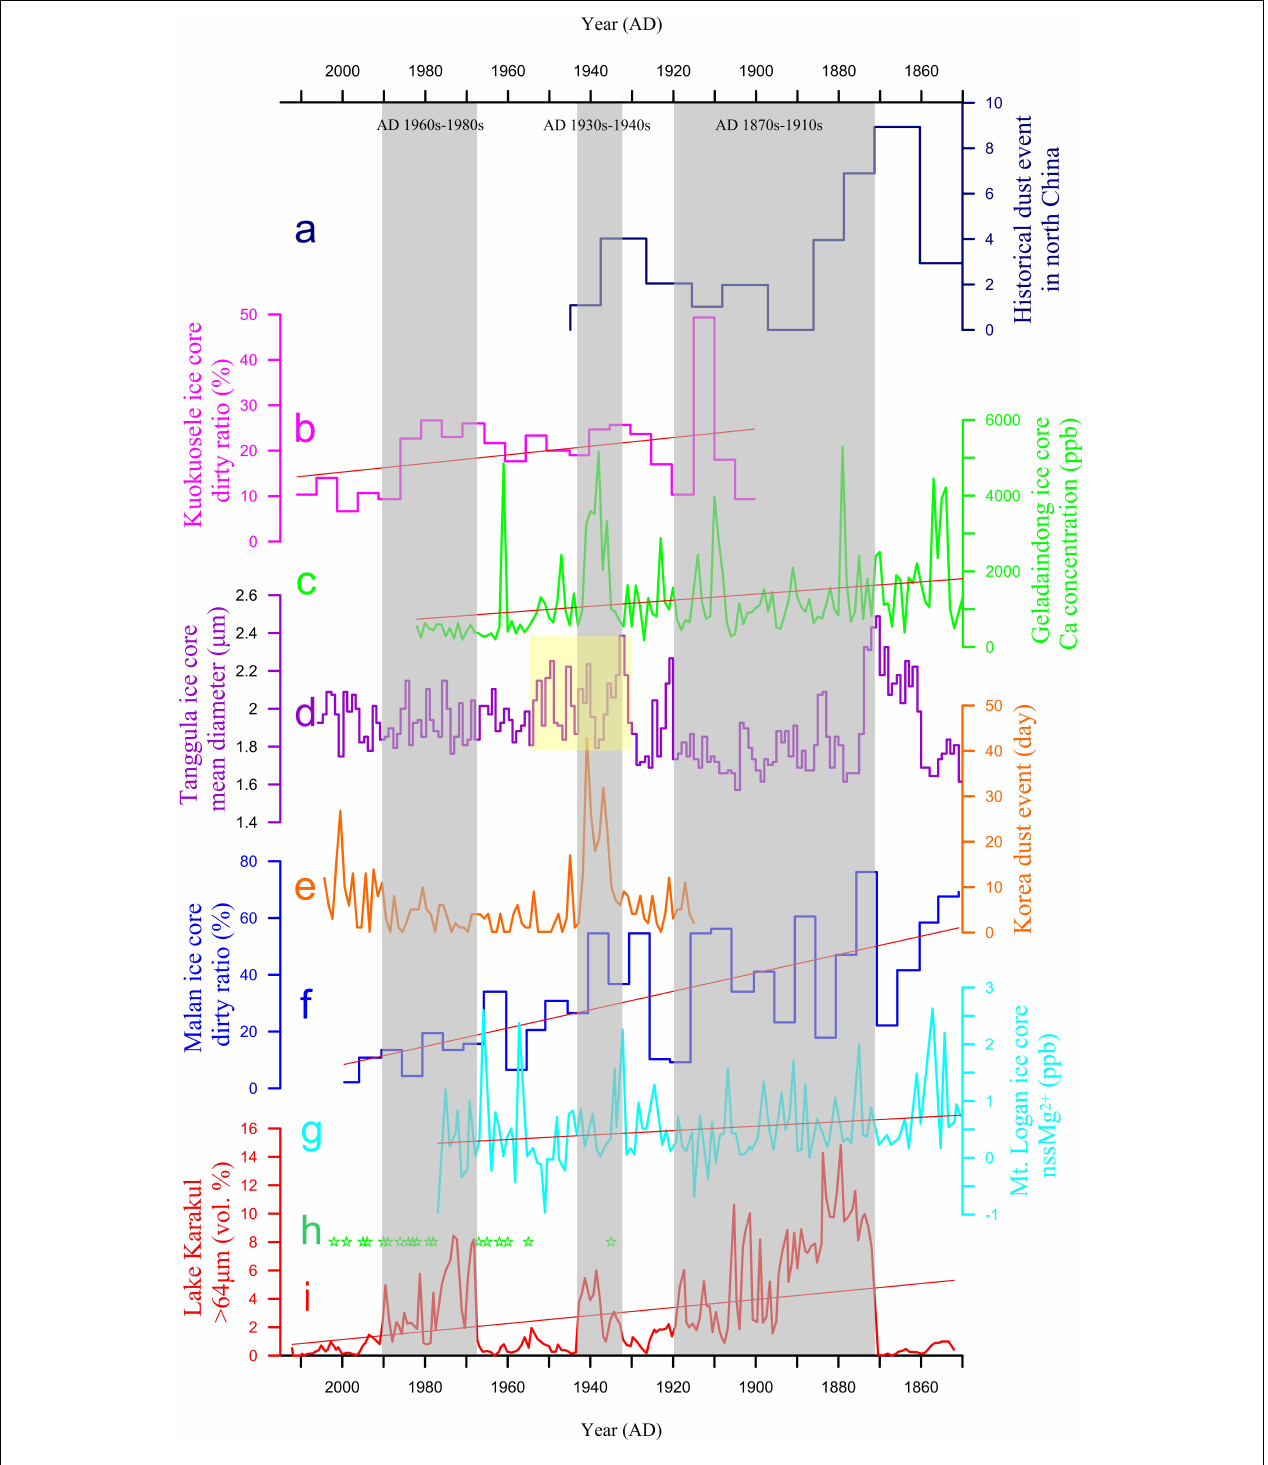
FIGURE 4 | Comparison between dust storm history at Lake Karakul (curve i; inferred from the > 64 µ m sedimentary gain-size fraction; this study), historical dust events frequency records in northern China (curve a; Zhang, 1984), dirty ratio in the Kuokuosele ice core (curve b; Tenzin et al., 2016), Ca concentrations in the Geladaindong ice core (curve c; Grigholm et al., 2015), mean diameter of dust in the Tanggula ice core (curve d; Wu et al., 2013), historical dust events in Korea (curve e; Chun et al., 2008), dirty ratio in the Malan ice core (curve f; Wang et al., 2007), nssMg 2 + from ice core in Mt. Logan, Canada (curve g; Kang et al., 2003), and historical dust event records around Lake Karakul (curve h; He et al., 2004). Red thin lines in plots b, c, f, g, and i show the linear trends; the vertical gray shaded bars indicate high frequent/intensive dust storm stages; the pale-yellow rectangle in curve d shows the AD 1930s–1950s dustiness period recorded in Tanggula ice